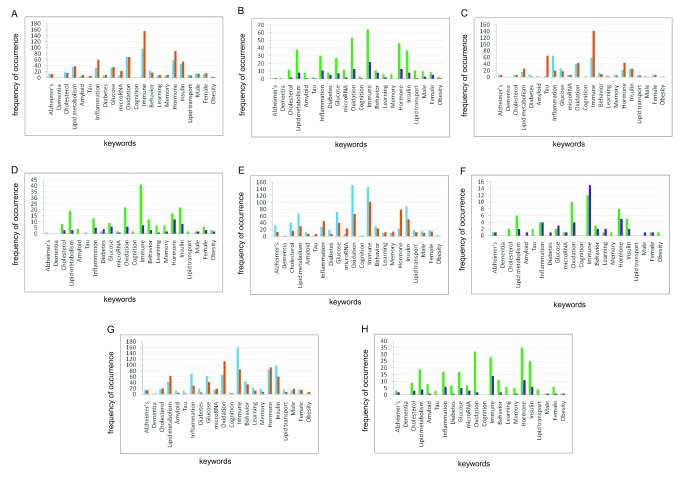
Keyword enrichment.Representative keyword enrichment based on GO Term classification. (
A) Females and (
B) males, frontal white matter; (
C) females and (
D) males, hippocampus; (
E) females and (
F) males, parietal cortex; (
G) females and (
H) males, temporal cortex. X-axis, keyword categories; Y-axis, frequency of occurrence.